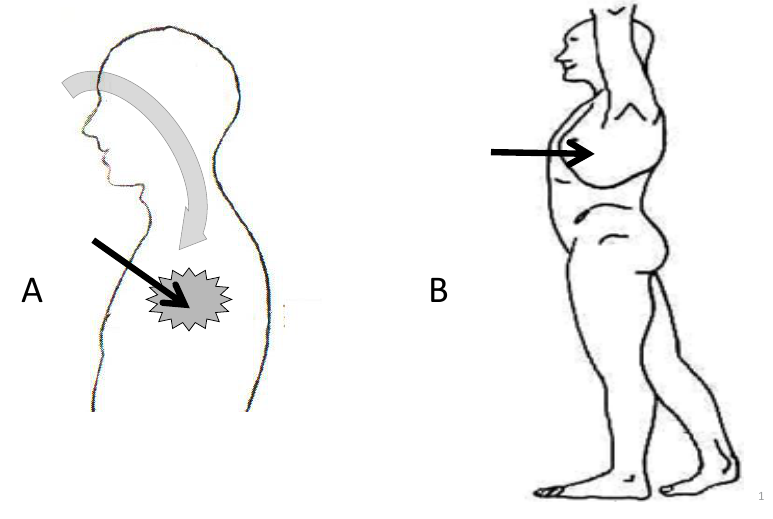
Figure 3. Refocusing (A) and absorption (B) of the somatic ego-sense in the Prayer of the Heart. Between the initial reversal of intentional consciousness onto the self, and the full cessation of